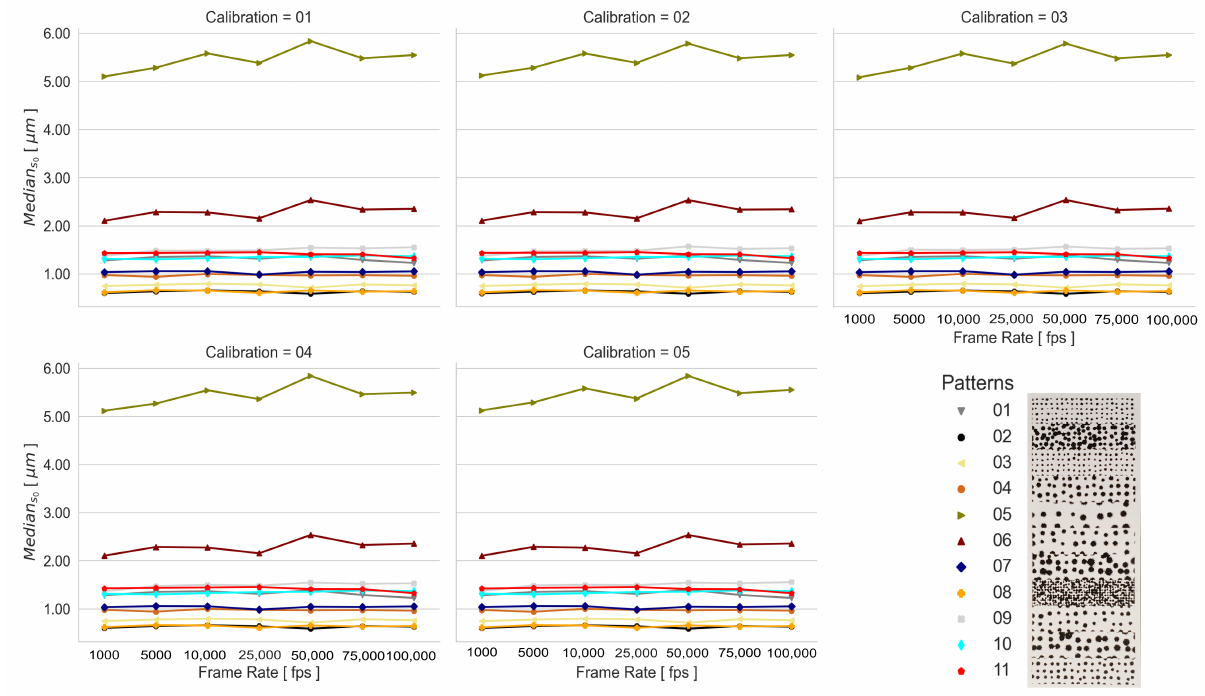
Figure A2. Median s 0 of the transformations obtained from the static SP experimental